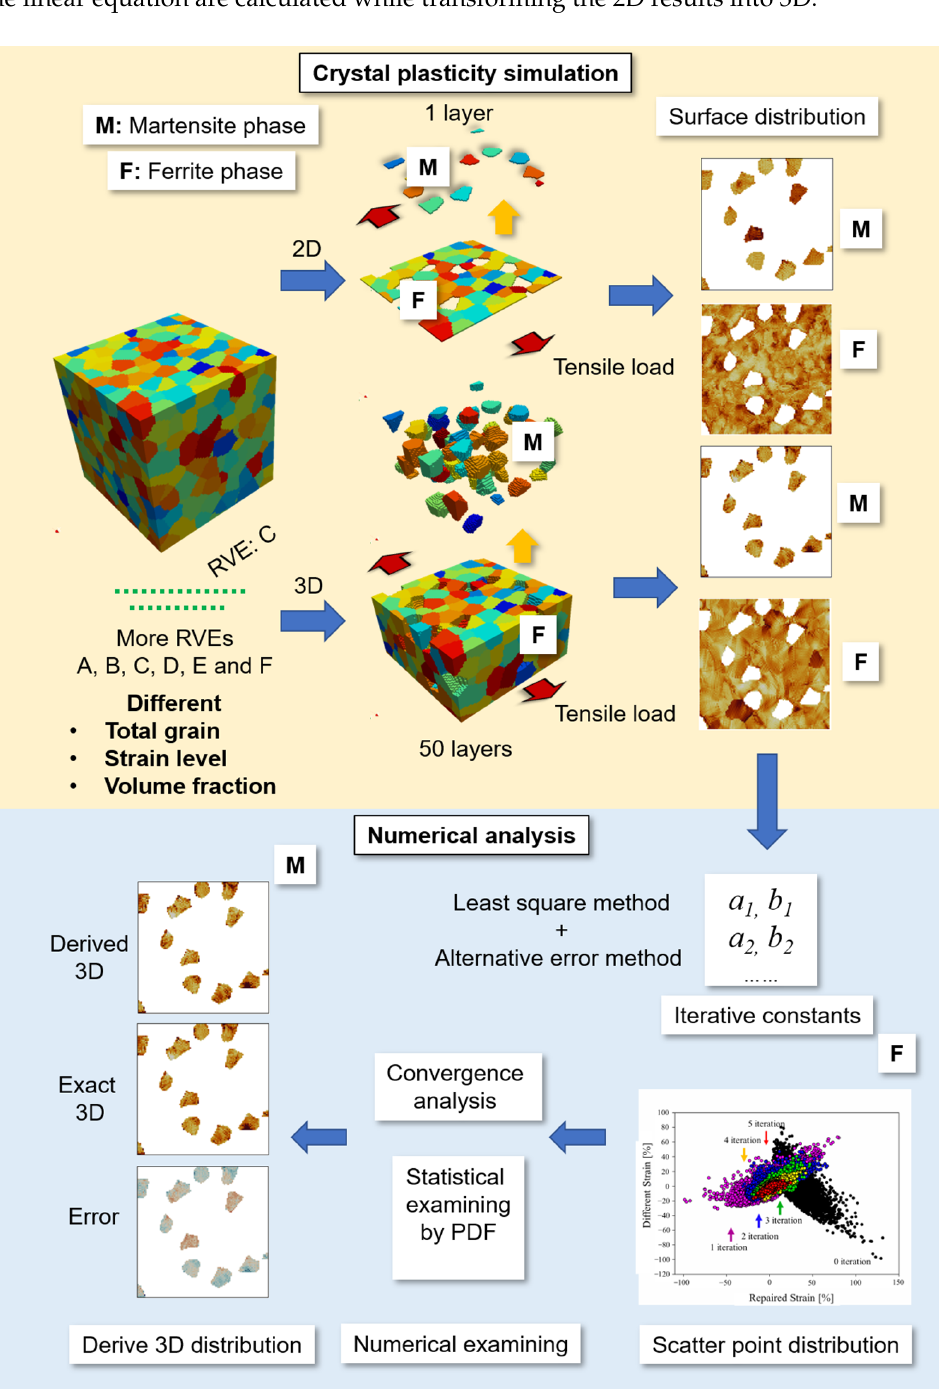
Figure 1. The schematic diagram represents the flow chart of the current work. The upper half (yellow background) indicates the flow chart of crystal simulation, and the bottom half (blue background) represents numerical analysis. The blue arrow indicates the flow of data. The red arrow represents tensile loading, and the yellow arrow separates the ferrite (F) and martensite (M) phases.